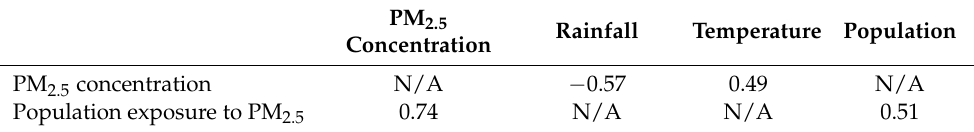
Figure 5. Correlation of PM 2.5 concentration and hospital admissions due to PM 2.5 in each morbidity. Table 2. The correlation coefficient